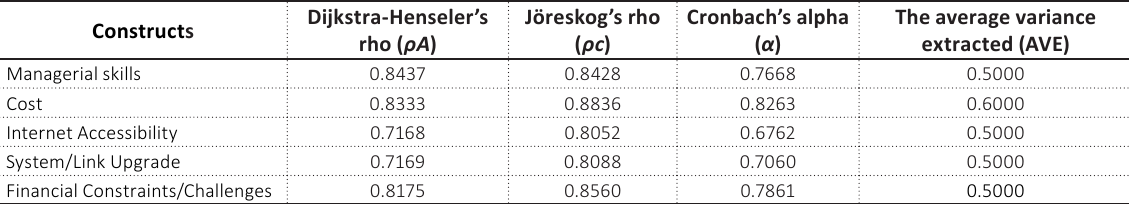
Table 3. Construct reliability and validity